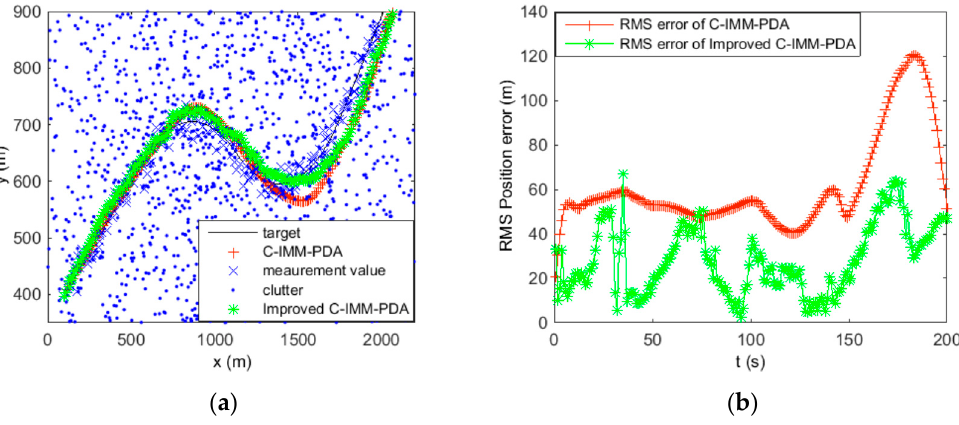
Figure 7. Maneuvering target tracking using C-IMM-PDA and improved C-IMM-PDA when clutter λ = 10. ( a ) Tracking of the target position; and ( b ) RMS position error of the